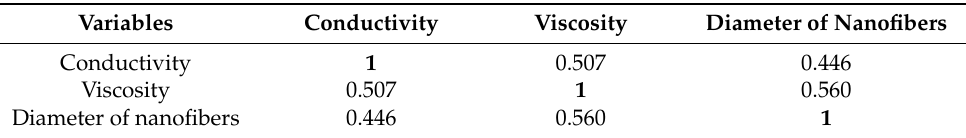
Table 5. Pearson correlation matrix for emulsion properties: viscosity, conductivity, and diameter of the nanofibers produced with the emulsions prepared.